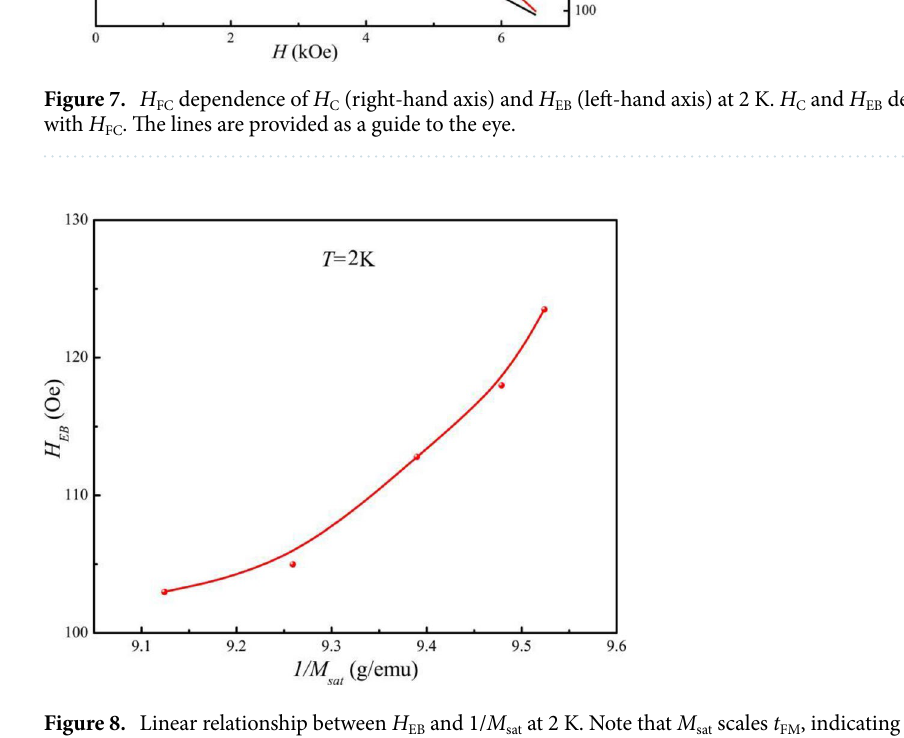
Figure 8. Linear relationship between H EB and 1/ M sat at 2 K. Note that M sat scales t FM , indicating that the exchange bias in bulk BSFCO follows H EB ∝ 1/ t FM .